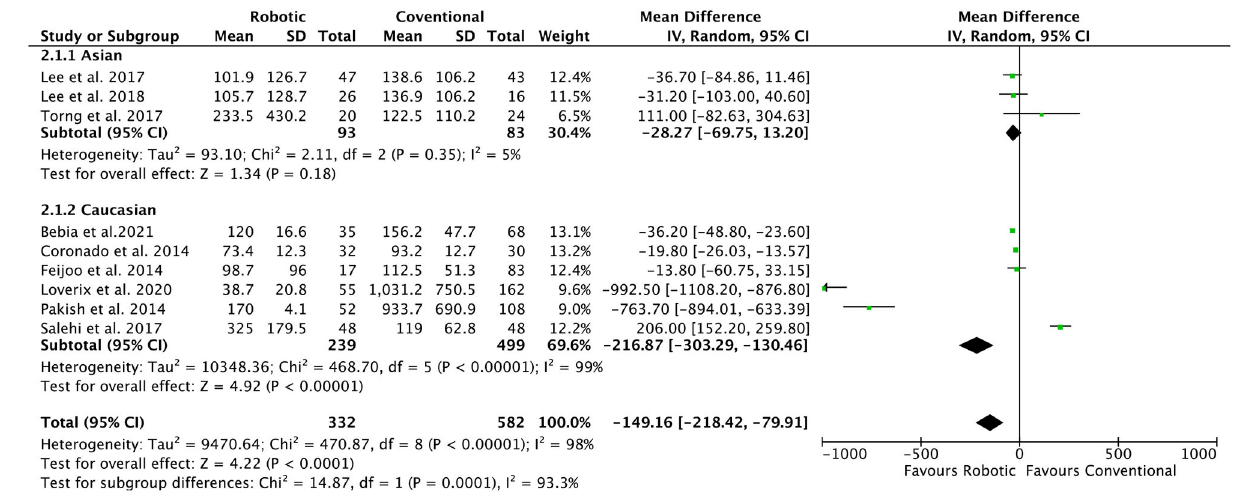
CI: − 154.2 to − 7.5; I 2 = 98%), and non-RCT study design (MD = − 245.8, 95% CI: − 403.4 to − 88.2; I 2 = 98%). However,